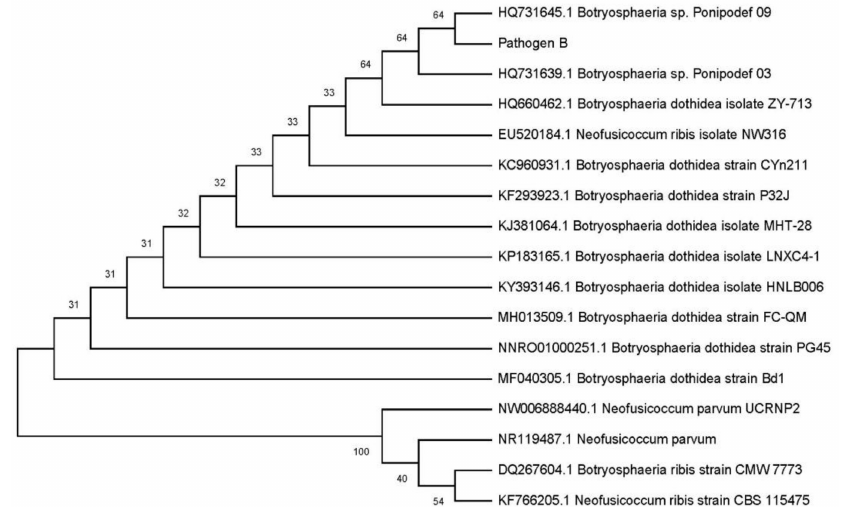
Figure 6. Phylogenetic tree of Botryosphaeria species. The evolutionary history was inferred using the neighbor-joining method [24]. The evolutionary distances were computed using the maximum composite likelihood method [25], and the numbers are shown near the branches.